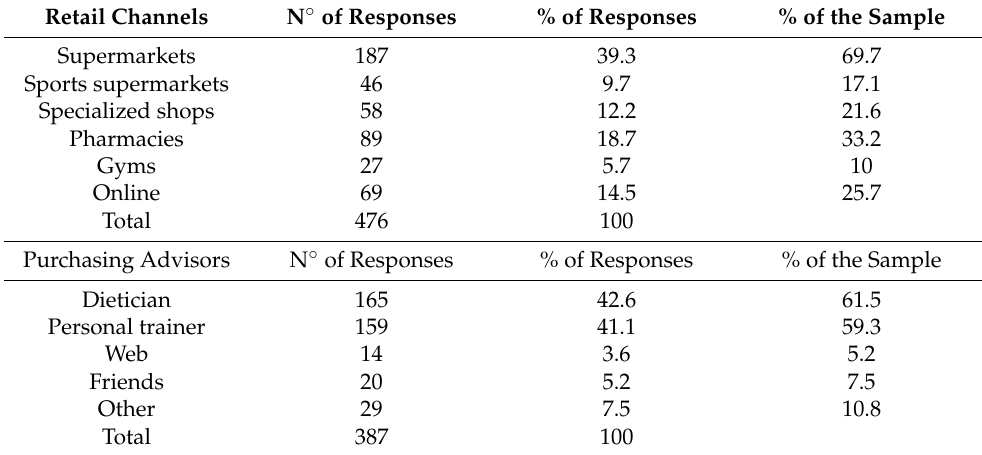
Table 11. Consumers’ favorite retail channels, purchasing advisors for the gathering of information, and purchase advise about caffeine-containing products for sport